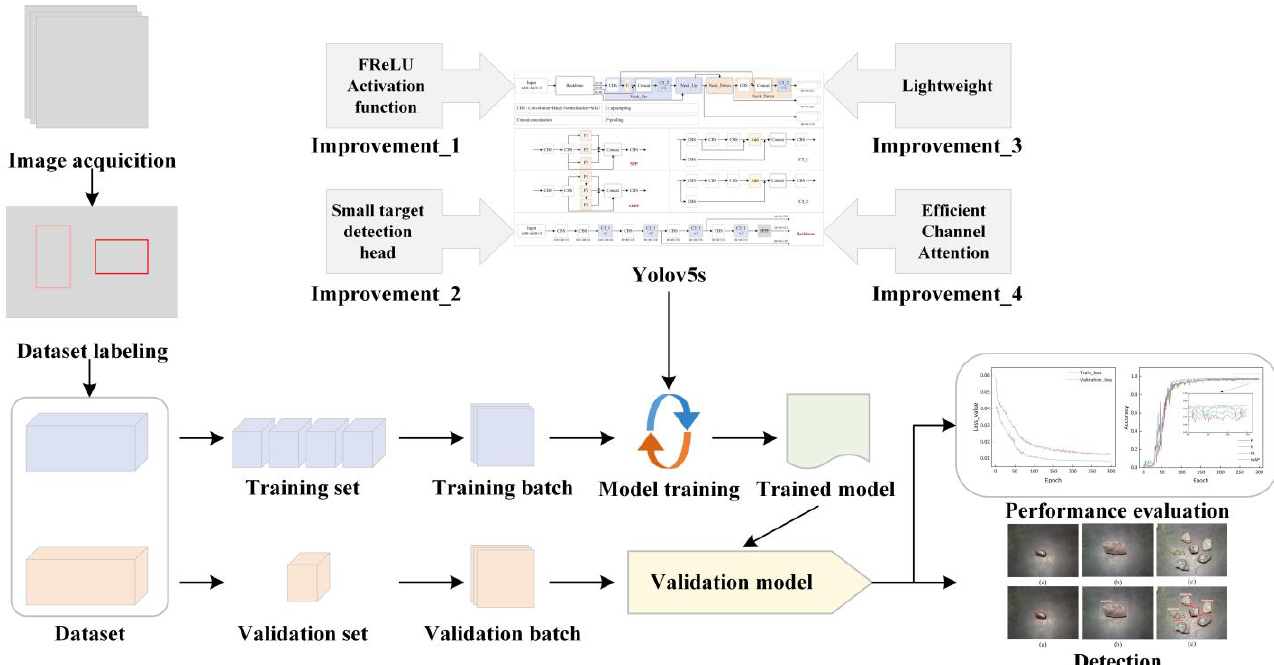
Figure 6. Workflow diagram of the proposed algorithm.